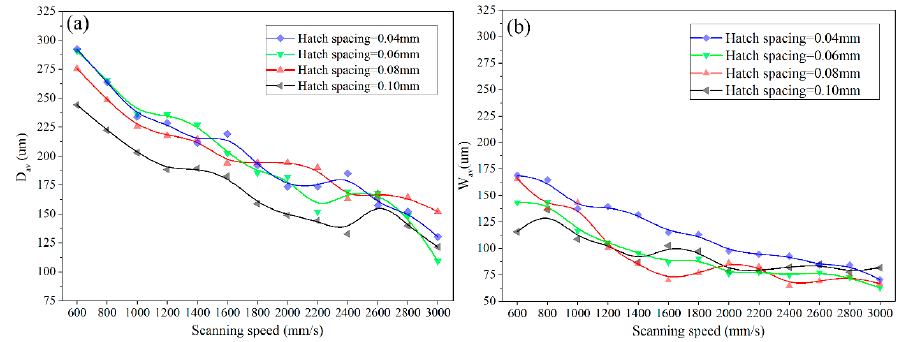
Figure 7. The average depth ( a ) and half width ( b ) of molten pools under different processing parameters.